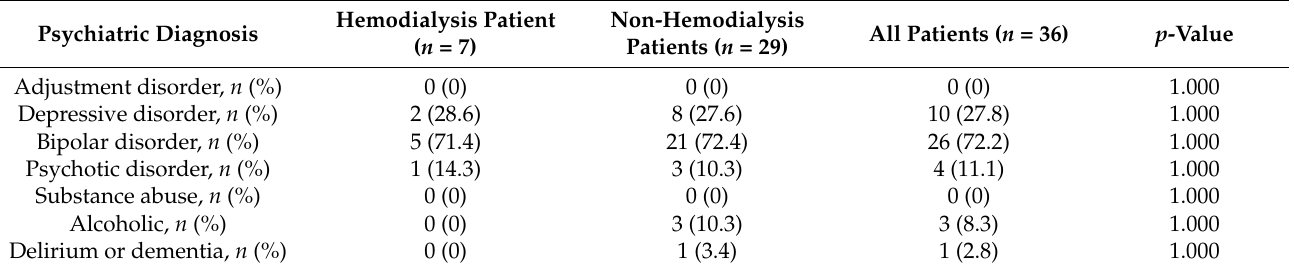
Table 3. Psychiatric comorbidities of patients with lithium poisoning, stratified according to whether they were treated with hemodialysis or not ( n = 36).